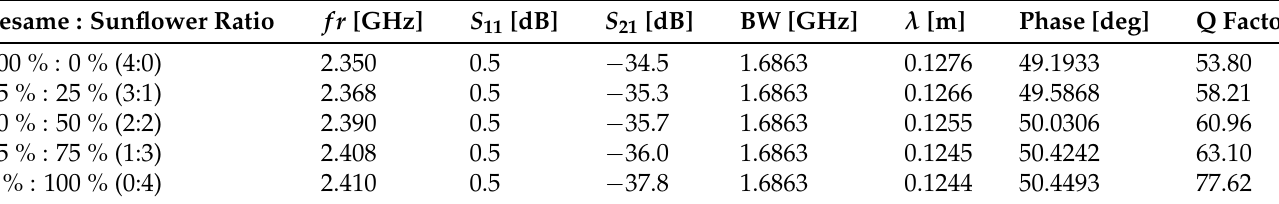
Table 13. Adulteration testing in sesame